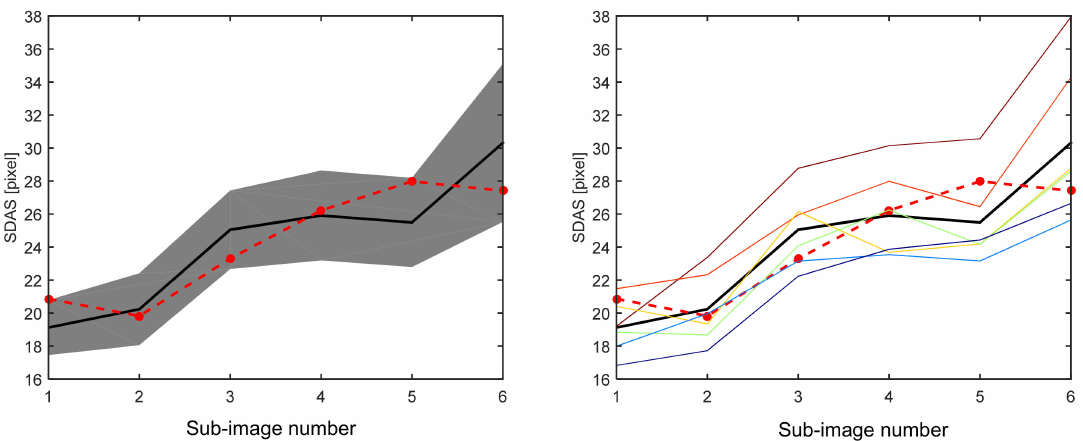
Figure 5. Comparison between the automated and manual SDAS measurements for the low eutectic structure; (left): comparison of the automated (red, dashed)–and manually measures (black, thick) SDAS values to the standard deviation (gray shaded region) of the distribution of manually measured SDAS values; (right): comparison of the automated (red, dashed)–and manually measures (black, thick) SDAS values to the individual manual SDAS measurements (thin,